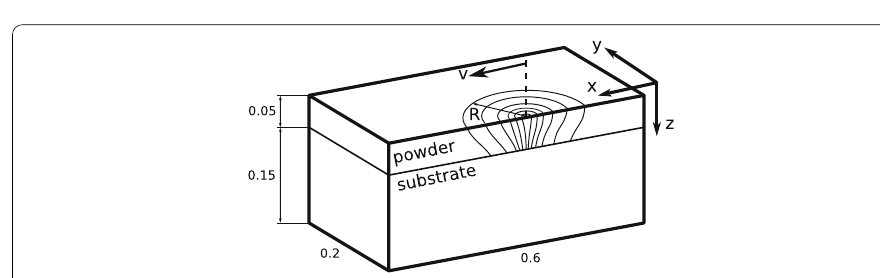
Fig. 14 Melting volume example: temperature profiles at t f obtained with AC methods for three time step sizes and with different phase change interval widths d . 100 elements